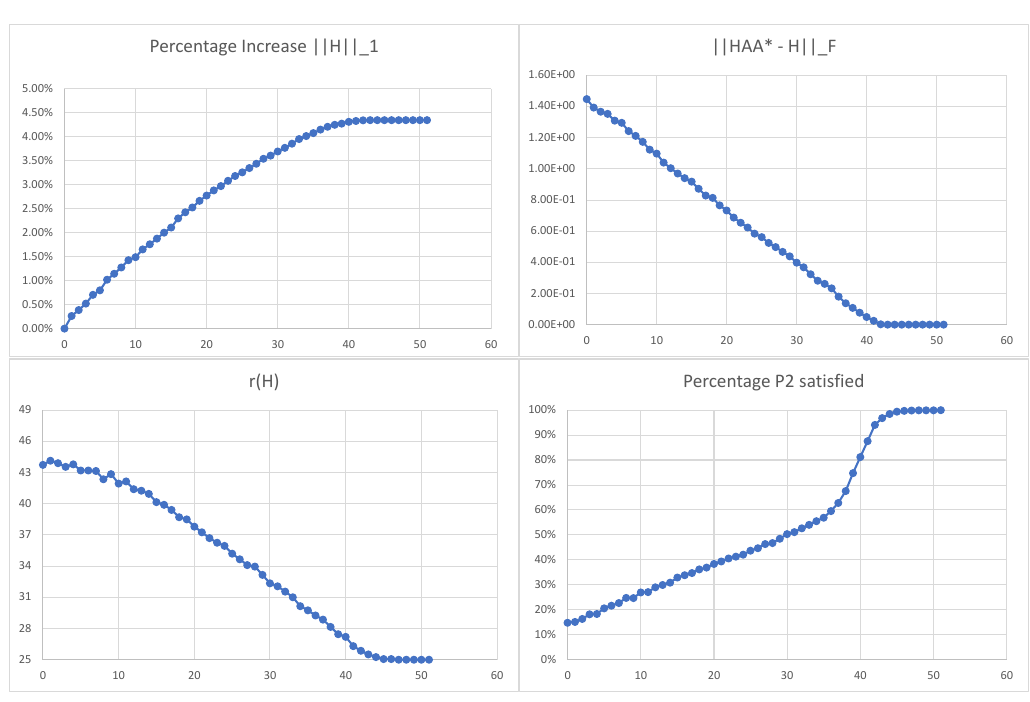
Figure 3 Cutting-plane